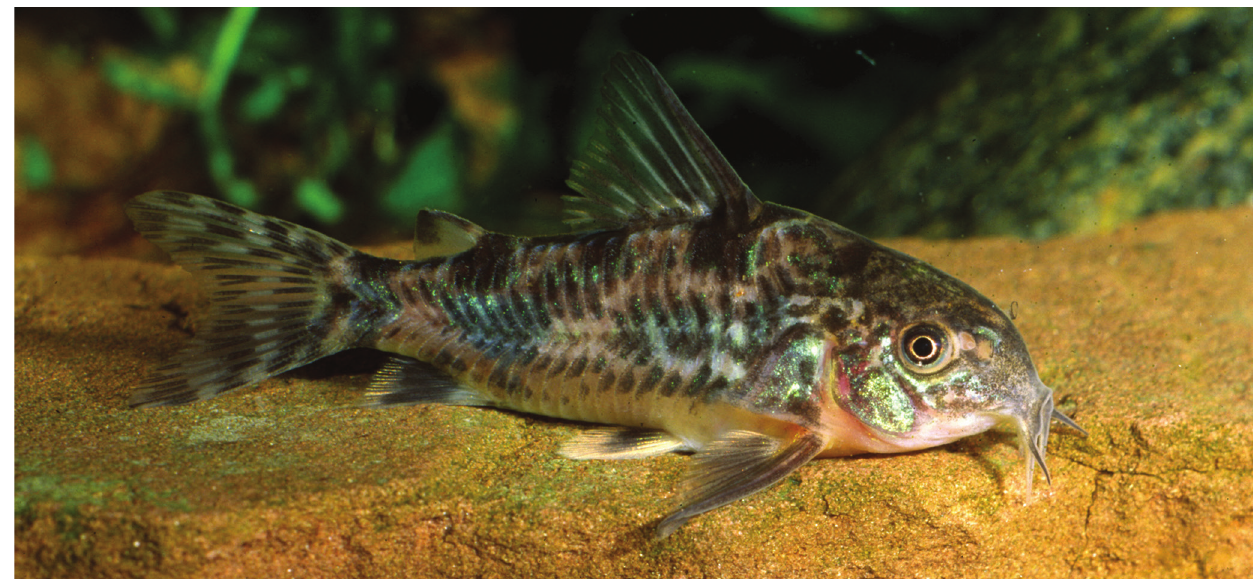
Fig. 10. Uncatalogued live specimen of Corydoras paleatus , with approximately 46.0 mm SL, from the rio Dulce basin, Entre Rios, Argentina. Photo by Hans-Georg